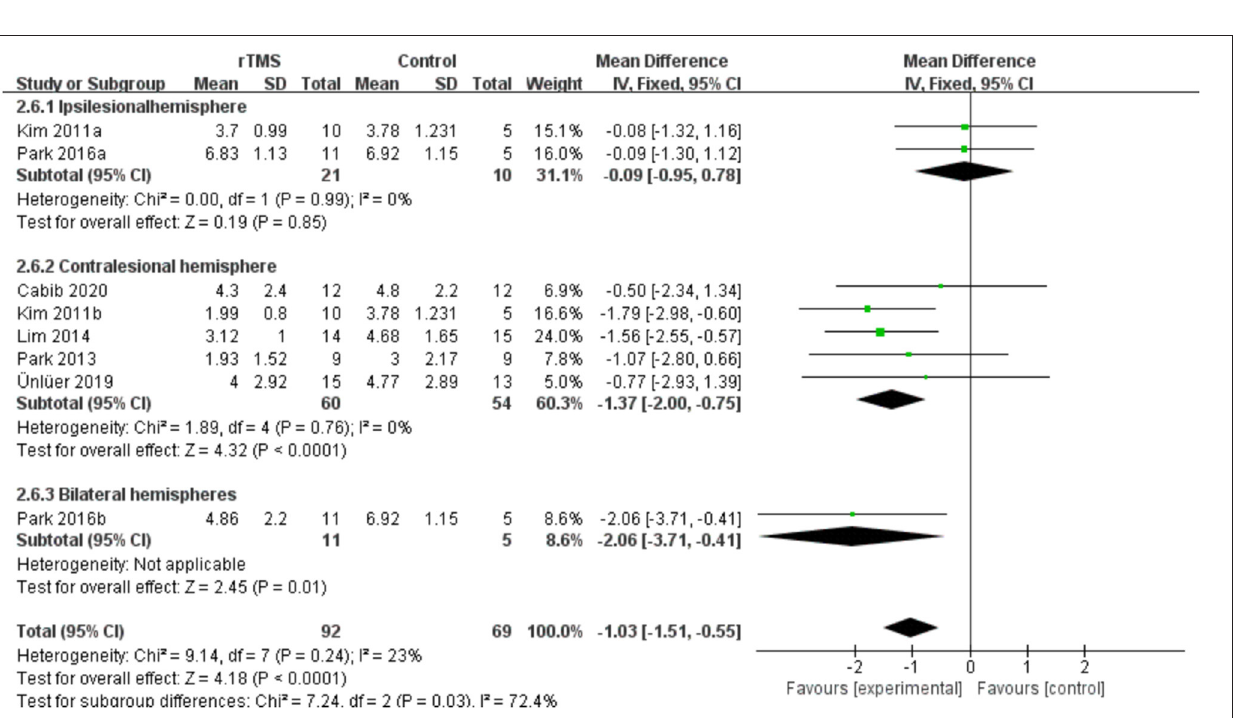
Subgroup Analysis of